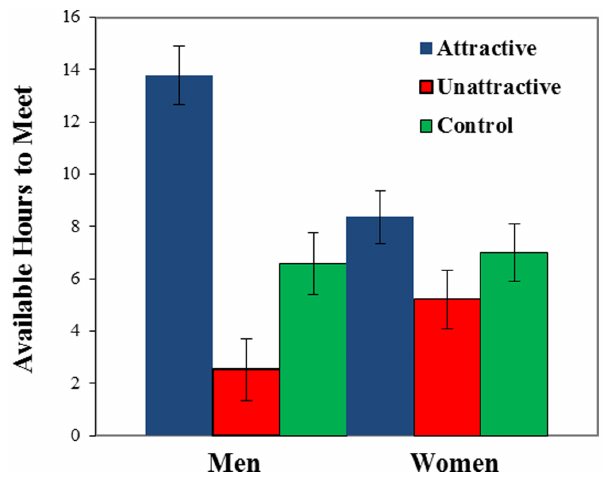
Figure 2. Hours available as a function of sex and partner. Note. Numbers represent the times participants reported being available to meet with their putative partner (see pamphlets in Supplementary Information S3 and S4). Bars represent standard errors.